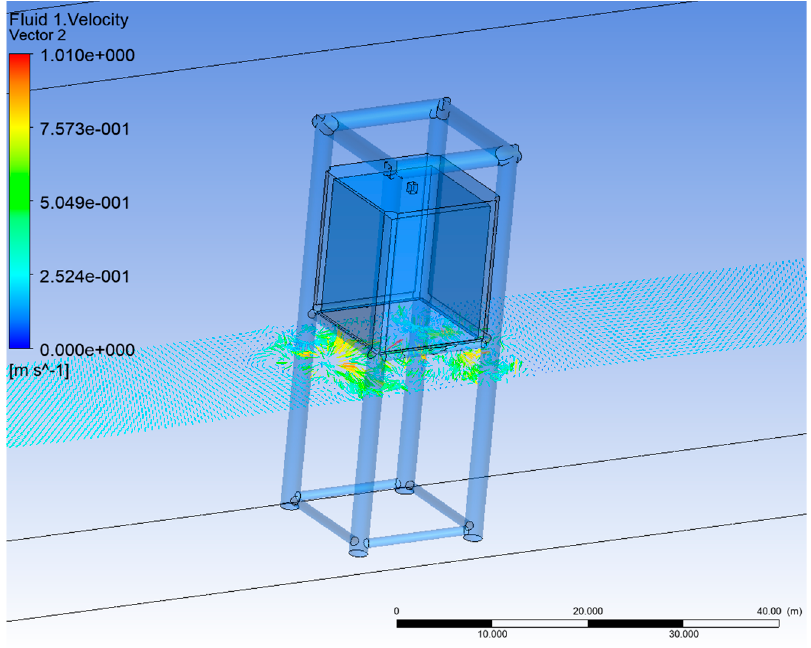
Figure 6. Fluid motions around the template structure with an air-chamber of the OWC.